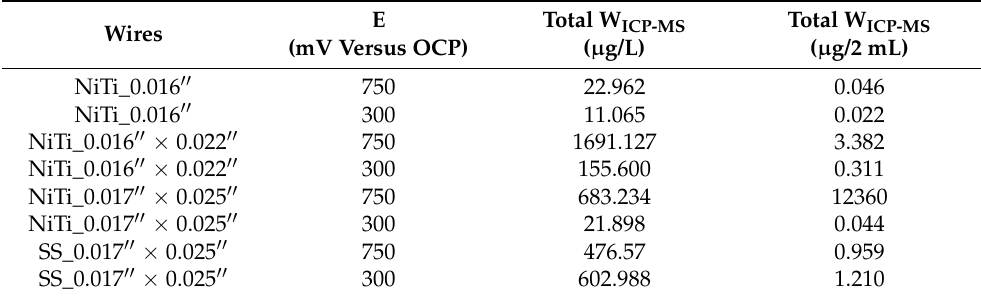
Table 13. A summary of the results of total W in µ g/L and µ g/2 mL from the ICP-MS analysis for the SS and NiTi wires with dimensions of 0.017 (cid:48)(cid:48) × 0.025 (cid:48)(cid:48) .